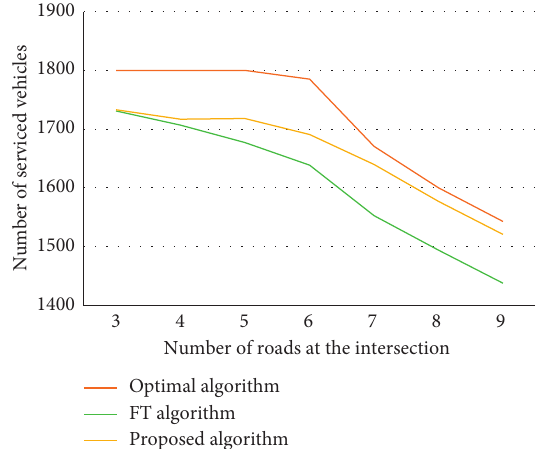
Figure 21: Effect of changing the number of roads at the inter- section (all the roads have the same traffic density that decreases with the increase of the number of roads) on the number of serviced vehicles using the OA, FT, and PA